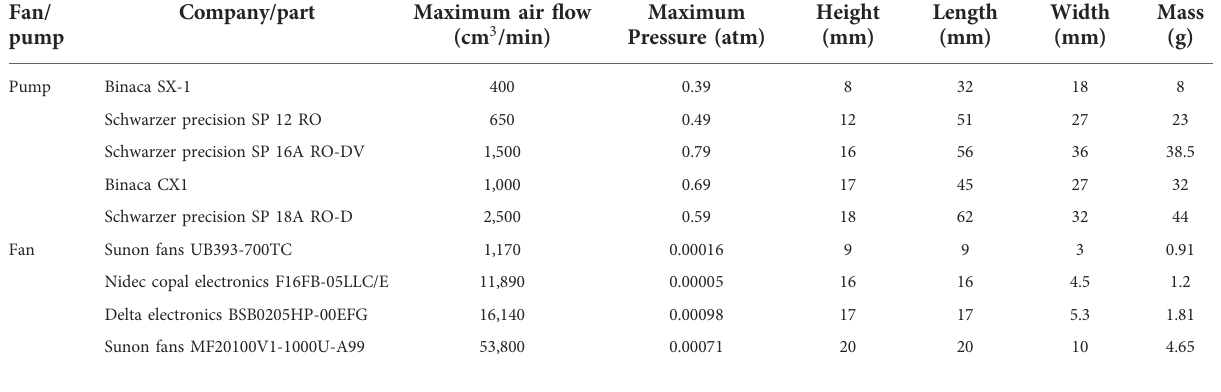
TABLE 1 Commercially available miniature air pumps and fans that meet the 20mm height constraint. Fan/